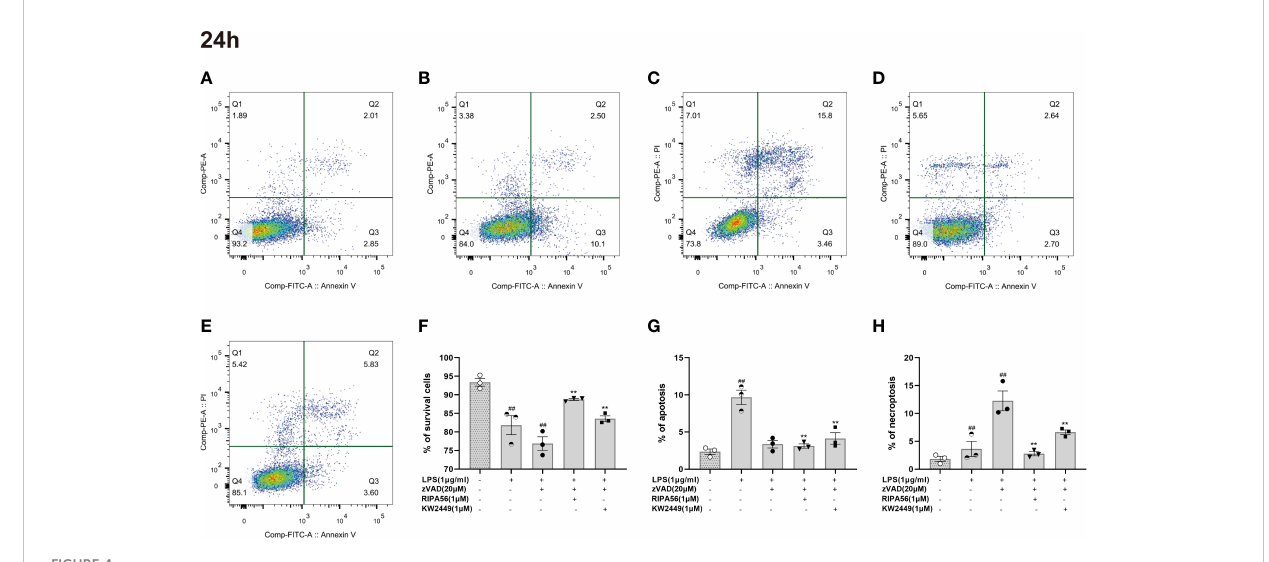
FIGURE 4 KW2449 reduced LZ-induced necroptosis in RAW 264.7 cells, as detected by fl ow cytometry using Annexin V-FITC/PI staining. (A-E) Representative graphs of cell death (24 h). (A) Control; B: LPS (1 m g/ml); C: LPS (1 m g/ml) + zVAD (20 m M); D: LPS (1 m g/ml) + zVAD (20 m M) + RIPA56 (1 m M); E: